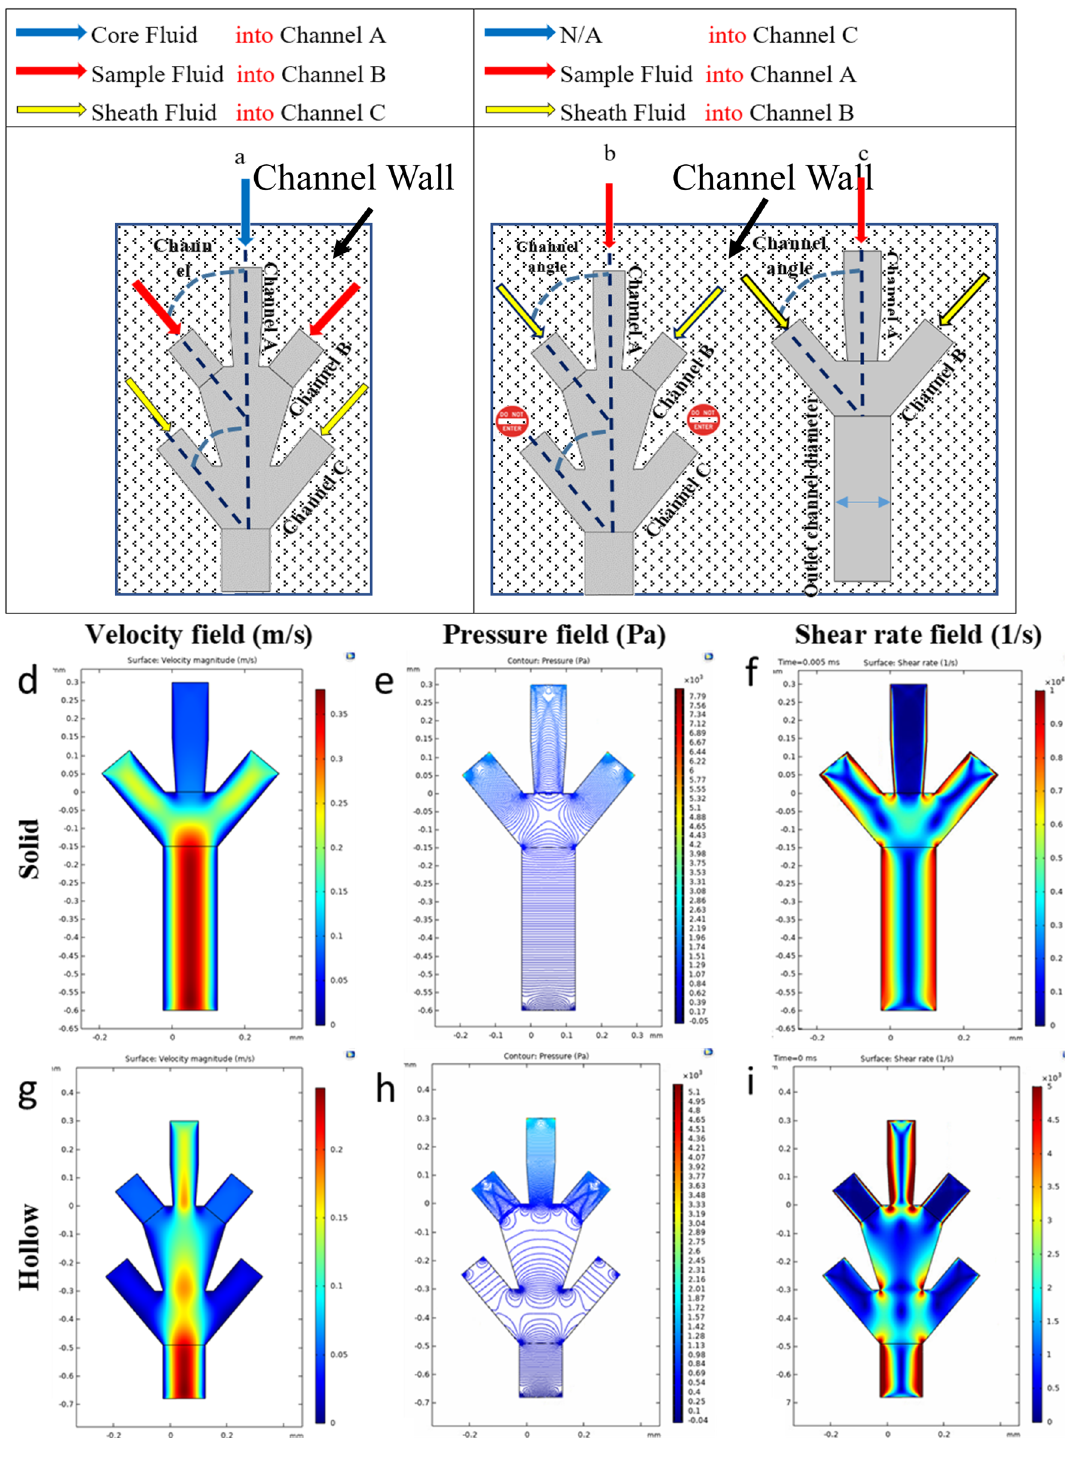
Figure 1. Schematic design of the microfluidic printhead and the numerical modeled parameters. ( a ) The schematic figure of the hollow microfiber fabrication system using the microfluidic channel, ( b ) The schematic figure of the solid microfiber fabrication system using the microfluidic channel. ( d – i ) Velocity field, pressure field, and shear rate field in the microfluidic channels embedded within the printhead system, ( d ) Flow velocity field of solid microfiber, ( e ) pressure field of solid microfiber, ( f ) Shear rate field of solid microfiber, ( g ) Flow velocity field of hollow microfiber, ( h ) pressure field of hollow microfiber, ( i ) Shear rate field of hollow